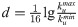
The correlation between the user degree and the taste similarity θ when the relations are created.The users are separated into 16 groups in terms of their degrees k
u. The step size of the degree within each group is set as d=116lgkumaxkumin, then the degree interval of the n
th group is [10n0+nd,10n0+(n+1)d], where n
0 = 2 and n ∈ {0, 1, ⋯, 15}. And only the average taste similarity θ at the relation creation time is considered for each group. (a) The joint impact of the taste similarity θ and the user degree k
u on trust formation. At the creation time of trust relations, the taste similarity θ continues to increase as the user degree k
u increases. And the correlation between the taste similarity θ and the user degree k
u is well fitted by a straight line. Thus the users relation status can be regarded as two status, that is, the unstable status in which the users’ taste similarity are not reach the value corresponding to the degree (area I), and the trust status in which the trust relation is created between a pair of users since their taste similarity exceeds the corresponding value (area II). (b) The number of relations counted for each group.